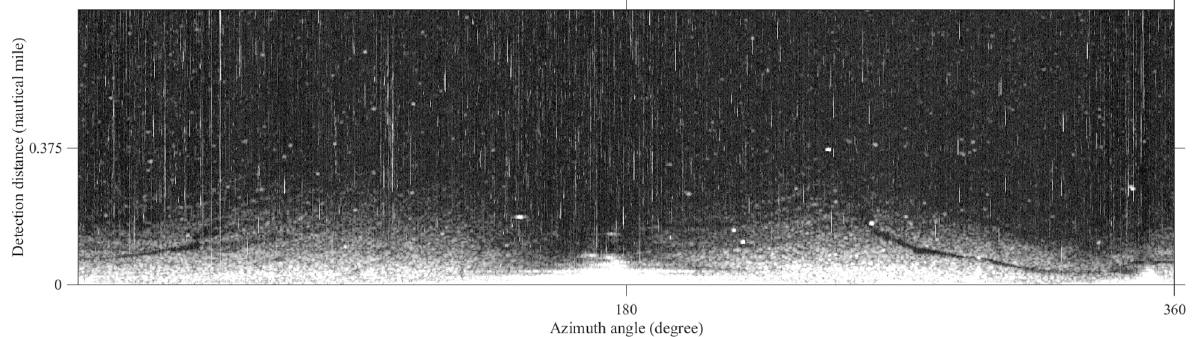
Figure 1. The original radar image.